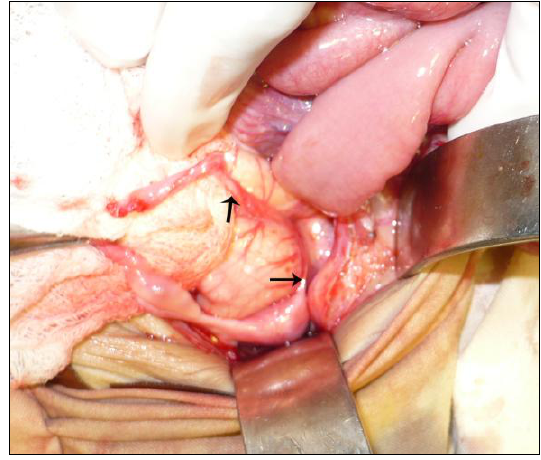
Figure 3: The portion of fallopian tube marked with two arrows was